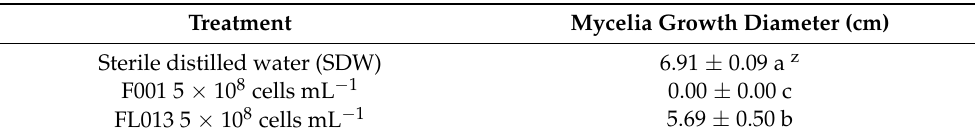
Table 5. Effects of diffusible substances generated by antagonist yeasts on C. gloeosporioides mycelia growth diameter after seven days incubation at 28 ◦